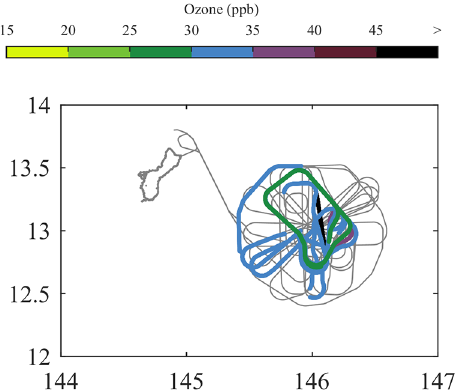
Figure 16. Flight track of RF02 with each profile coloured by mean tropospheric ozone as in Fig. 12. Of the 12 profiles taken, two pro- files have mean ozone concentrations of 25–30ppbv, seven have 30–35ppbv, and two have 35–40ppbv.